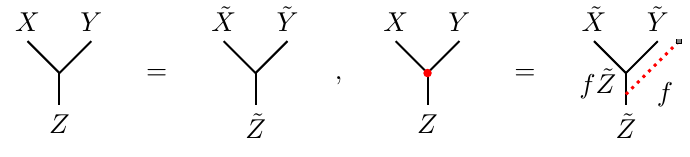
Figure 9 . The complex number λ represents the vacuum splitting into two fermions with end points. Here the red dotted line represents simple current fermion (quantum dimension = 1 ).